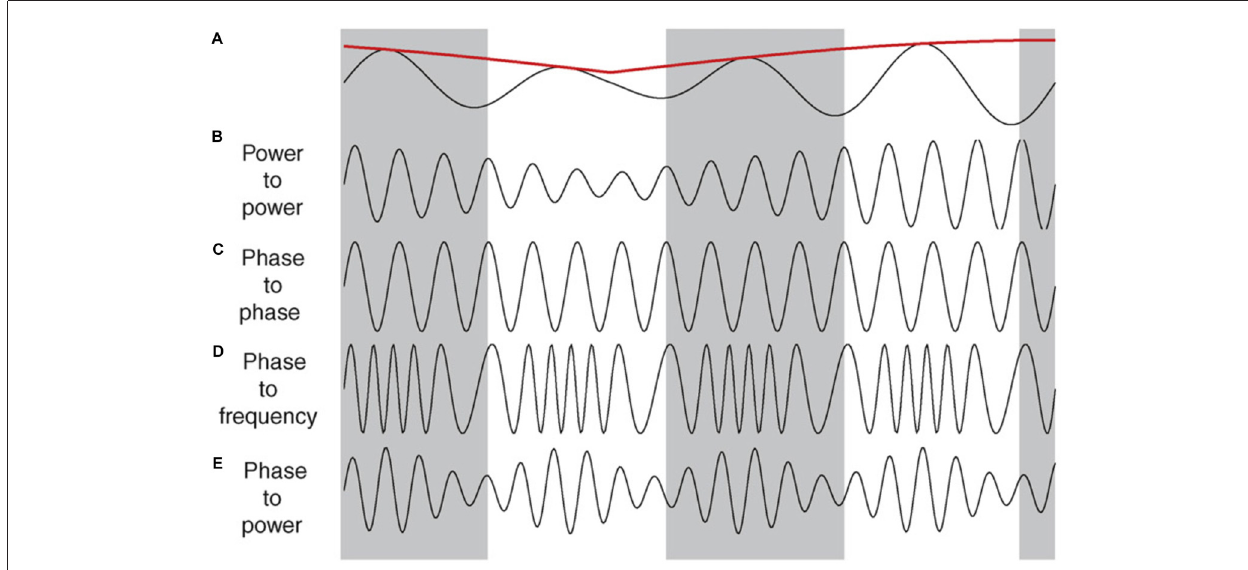
FIGURE 3 | Illustrations of cross-frequency coupling. (A) A slow oscillation in the theta range, along with its power indicated by the red line. (B–E) Illustrate the different types of interplay that faster oscillations (e.g., gamma) can have with the slower trace in (A) . (B) Power–power: the power (amplitude) of the faster wave correlates with the power of the slower wave. (C) Phase–phase: a fixed number of faster cycles within each phase of the slower oscillation. In this case there are four cycles within each phase. (D) Phase–frequency: the number of cycles in the faster wave correlates with specific phase of the slower wave. (E) Phase–power: the power of the faster wave correlates with the specific phase of the slower wave, independent of the power of the slower wave. Reproduced with permission from Elsevier (Jensen and Colgin, 2007).